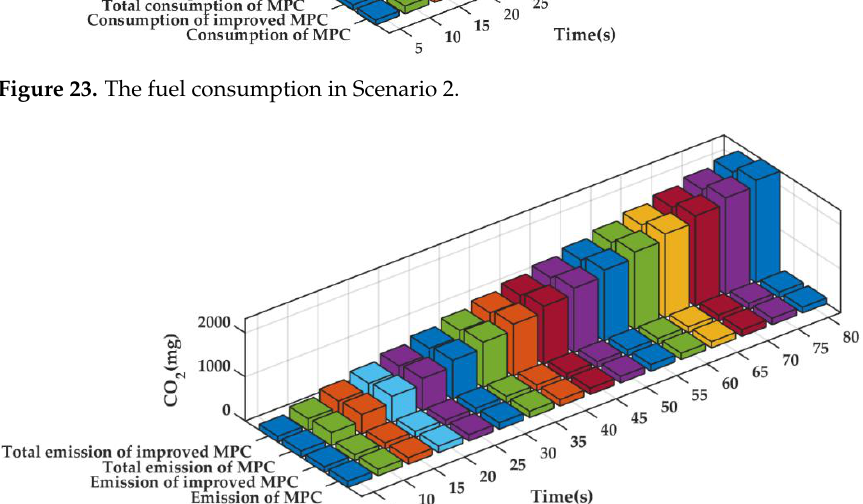
Figure 24. The carbon dioxide emissions in Scenario 2.